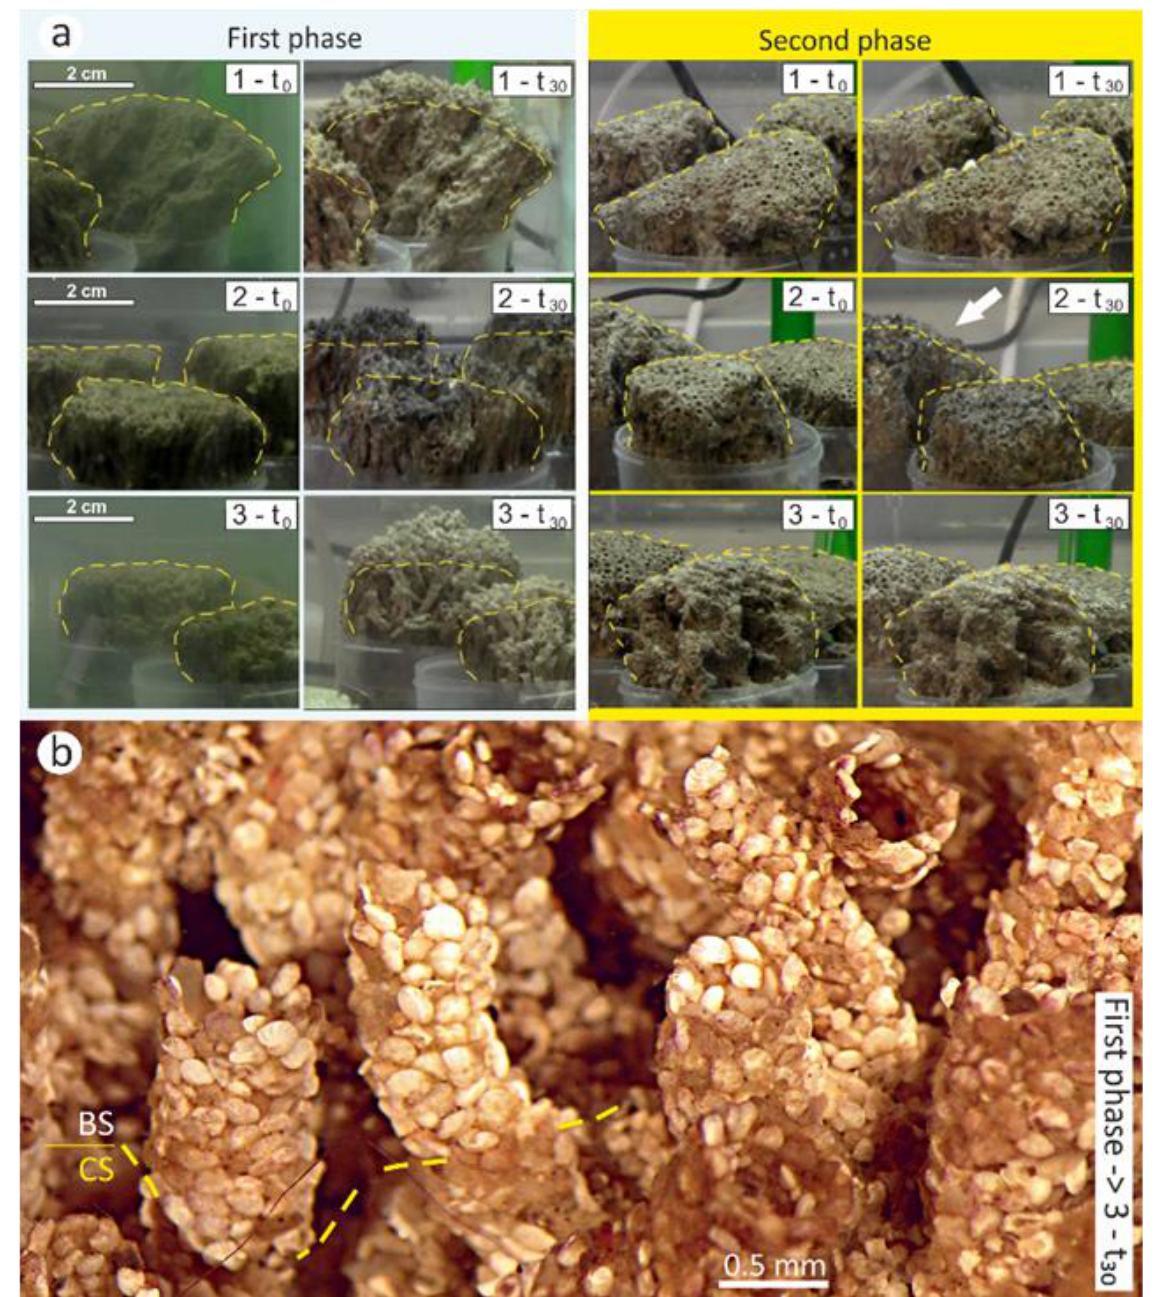
Figure 6. ( a ) Examples of reef growth during the two experimental phases (using different grain size sands). For each phase, the pre- (left) and post- (right) test morphologies of the biological replicas are shown for the three tanks containing sand of different compositions. Each example indicates the tank number (1, 2, or 3) and the moment of the photo (t 0 = first day and t 30 = last day of the test). Note how the photos taken before and after the tests clearly show the growth of biological replicas only in the first phase of the experiment. On the contrary, in the second phase (using coarser sands), the growths were very low, even if they were locally measurable (see the white arrow in the second-phase tank 2 — t 30 ). ( b ) After the experiments, tube growths in all biological replicas were measured manually. In the macro-photo, the growth of the tubes in the laboratory (using the bioclastic sands — BS) on the natural tubes (consisting of calcilithic sands (CS)) during the first phase of the experiment (tank 3 — t 30 ) is shown.